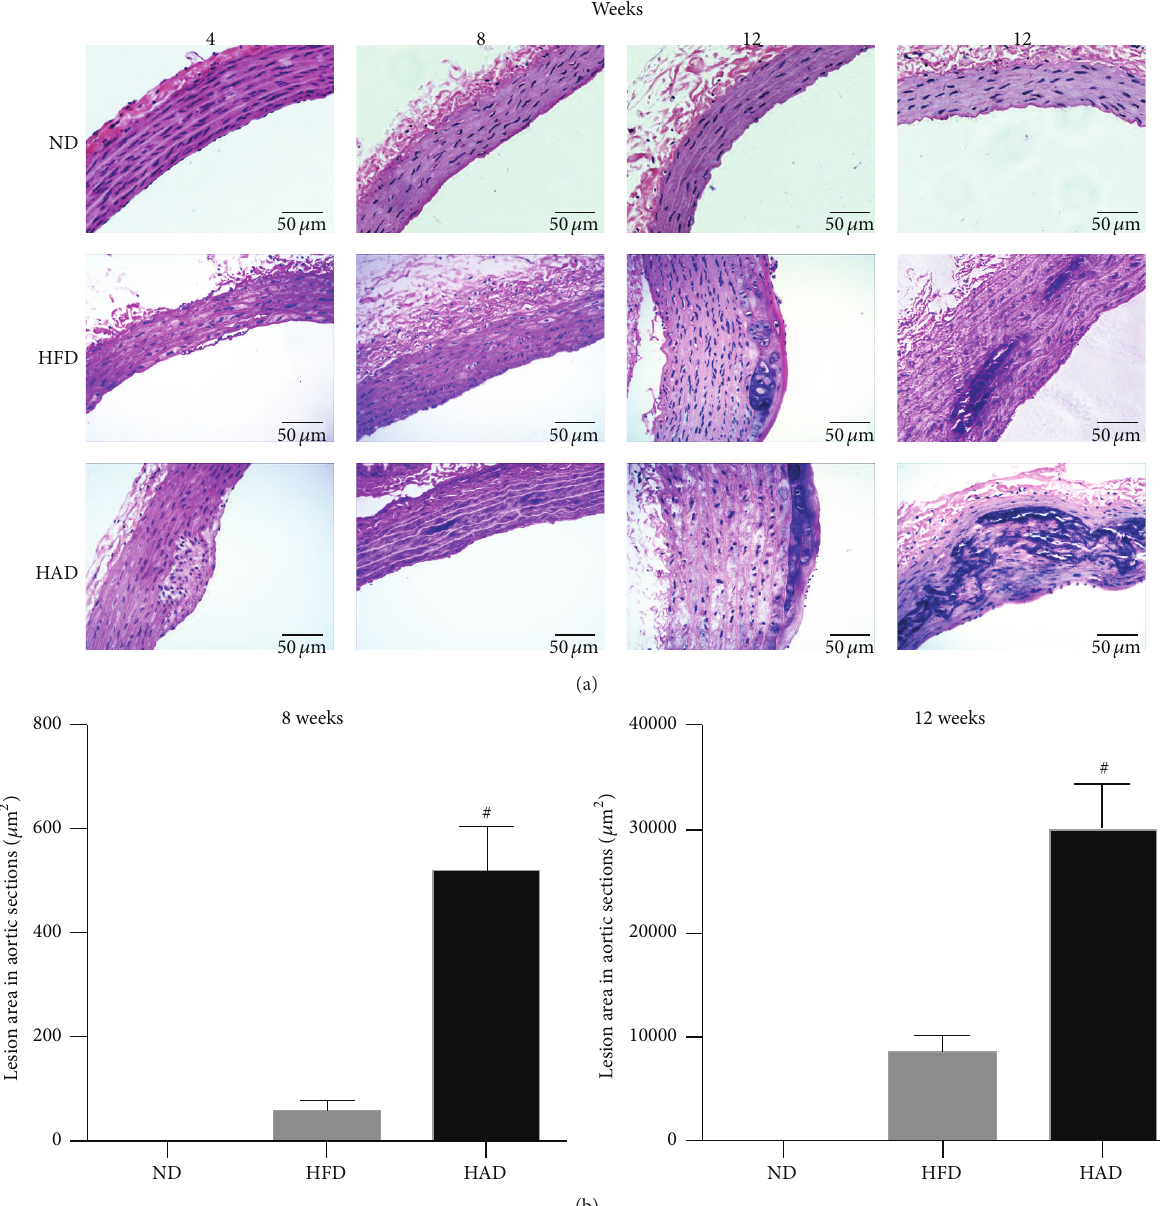
Figure 2: Histopathological examination of aorta in rats. All rats were sacrificed at 4, 8, or 12 weeks, respectively. (a) Aorta rings were stained with HE ( × 400 magnification). (b) Quantitation of lesioned area in HE-stained aorta sections using Image-Pro Plus software ( 𝑛 = 6 ). # 𝑃 < 0.05 , compared with the HFD